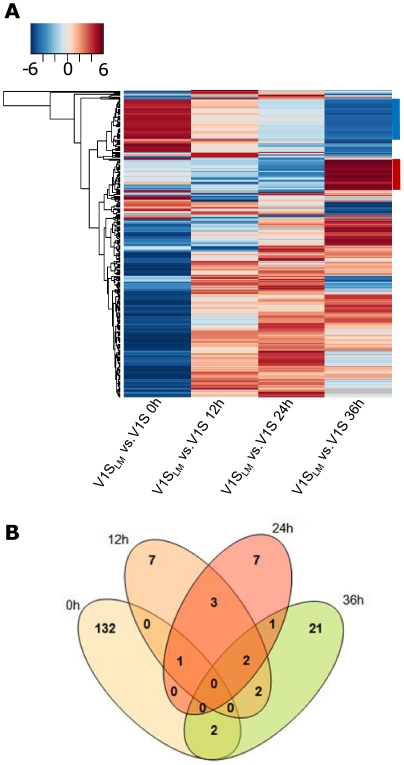
Changes in gene expression profiles between LM resistant V1SLM and LM sensitive V1S P. falciparum.
A. Heatmap of 589 expressed genes showing Differential Expression (DE) in at least one time point (F adjusted p<0.05). The 2 clusters highlighted with blue and red bars on the right hand side of the heatmap correspond to subtelomeric genes gradually switched off in the presence of LM, and transporters and cell cycle regulators gradually turned on in the presence of LM, respectively. Log2 ratio of V1SLM vs. V1S expression is indicated by the color key ranging from −6 (blue, under-expression) to 6 (red, over-expression) B. Venn diagram showing the asexual life cycle distribution of DE genes. Analysis was based on linear modeling using Limma package of R/Bioconductor.